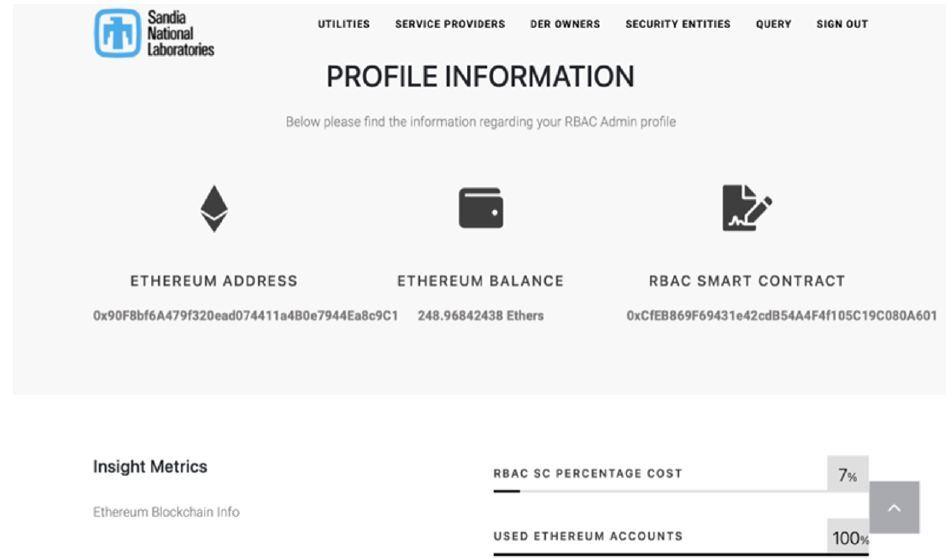
Figure 4. Ethereum Blockchain GUI: The logged user sees information about the Ethereum Blockchain